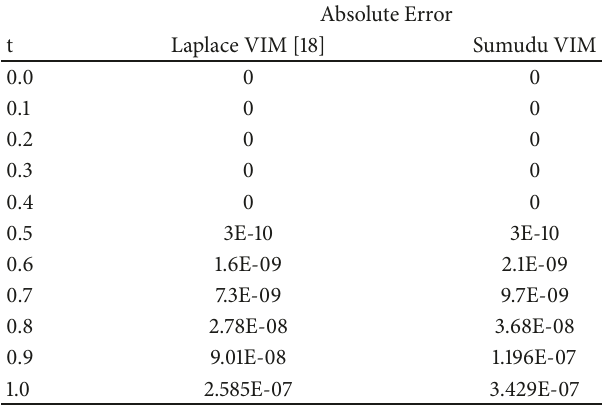
Table 2: Absolute error comparison representing Example